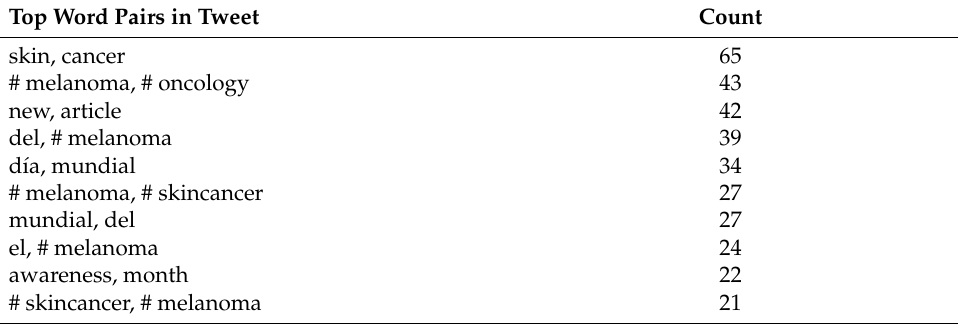
Table 2. Top 10 word pairs during the study period. Top Word Pairs in